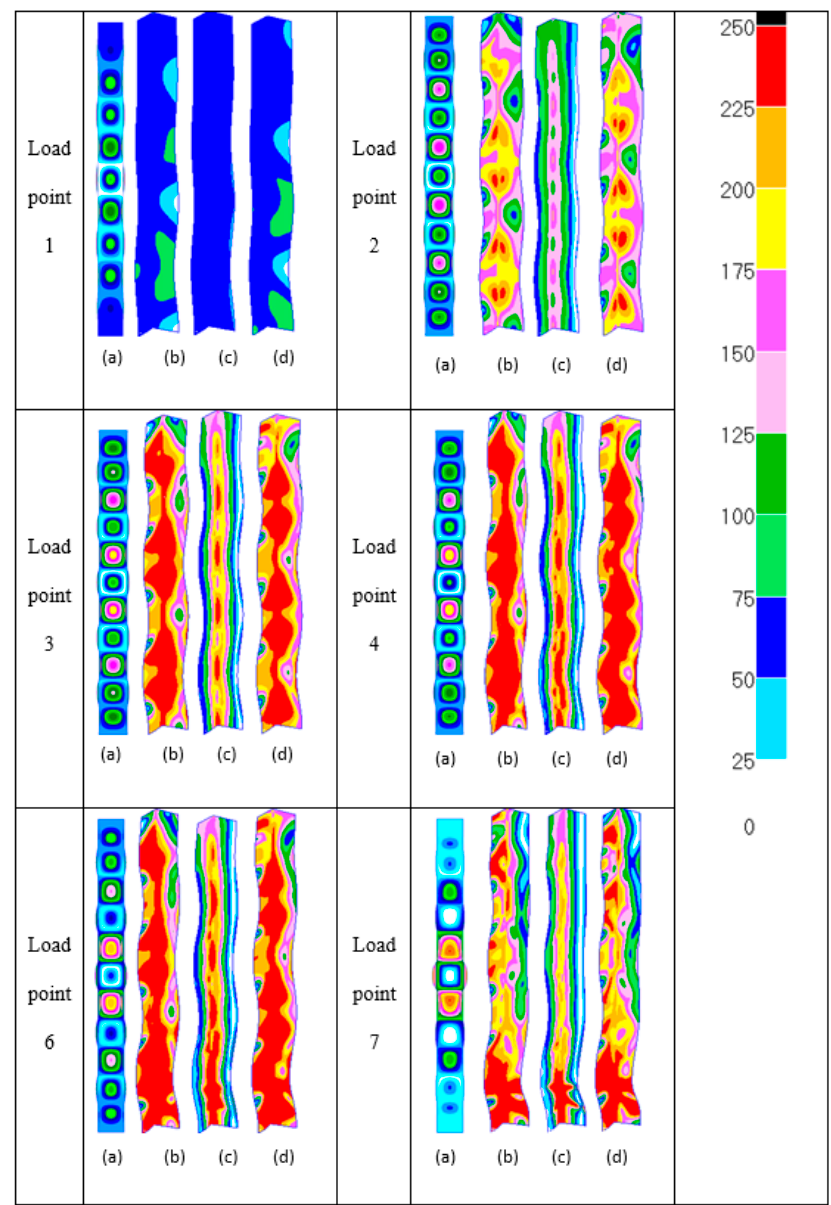
Figure 15. Deformation plots ( a ) and the growth of the von Mises stresses with load (( b ) outer surface 1; ( c ) middle surface; and ( d ) outer surface 2) of Figure 13 (quarter-model).